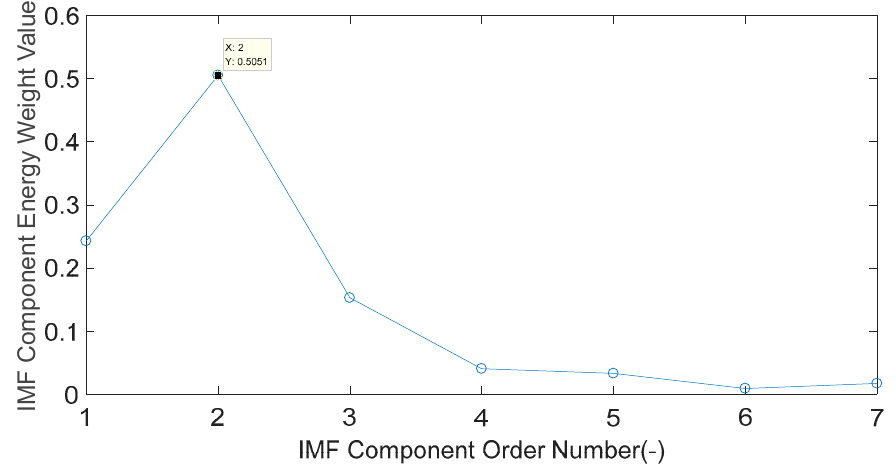
Figure 13. Each IMF component energy weight value of the engine block vibration signal under a weak knock condition at 5100 rpm.